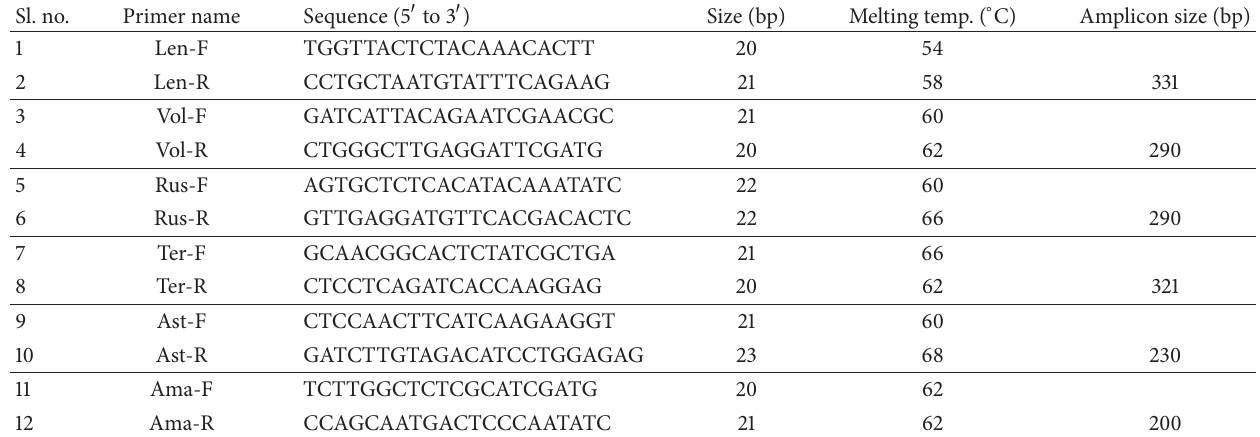
Table 1: Primers designed for different mushroom sample